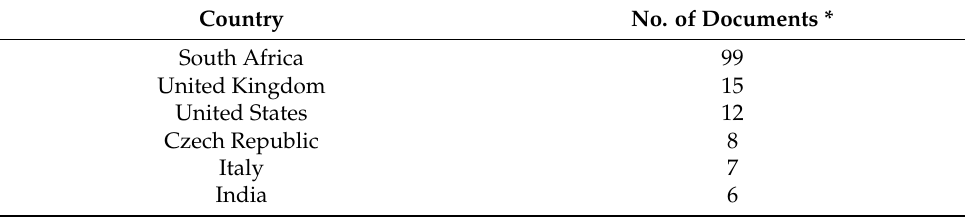
Table 2. Published documents on the genus Tulbaghia per